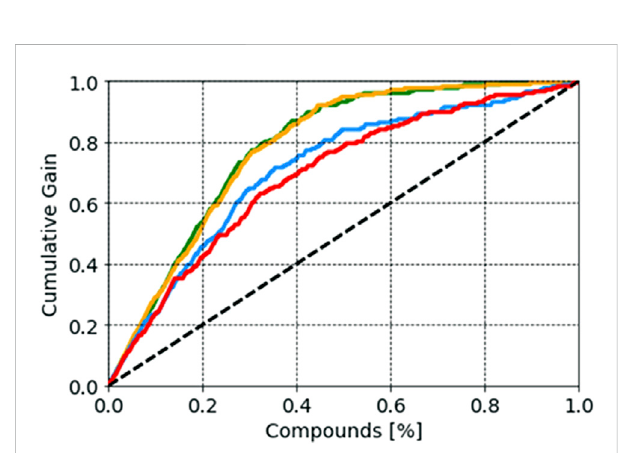
FIGURE 4 Probabilistic distribution plot showing cumulative gain for the developed